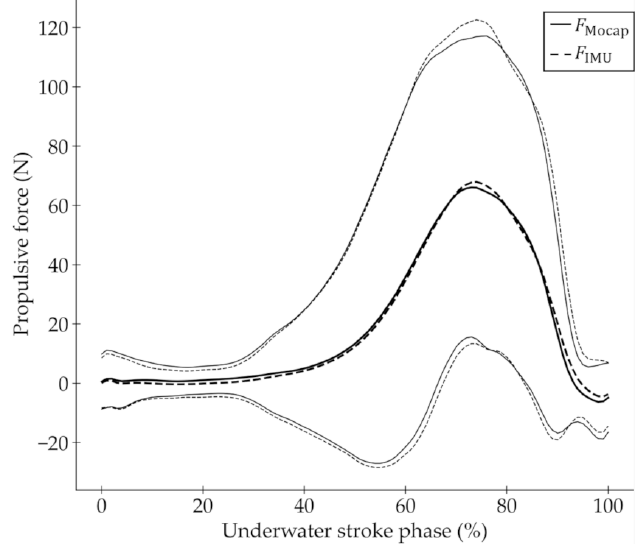
Figure 9. Ensemble means and standard deviations (SDs) for F Mocap and F IMU for all strokes. Ensemble means are shown as thick solid line ( F Mocap ) and thick dashed line ( F IMU ). Thin solid and thin dashed lines represent ± 1.96 SDs of F Mocap and F IMU , respectively.